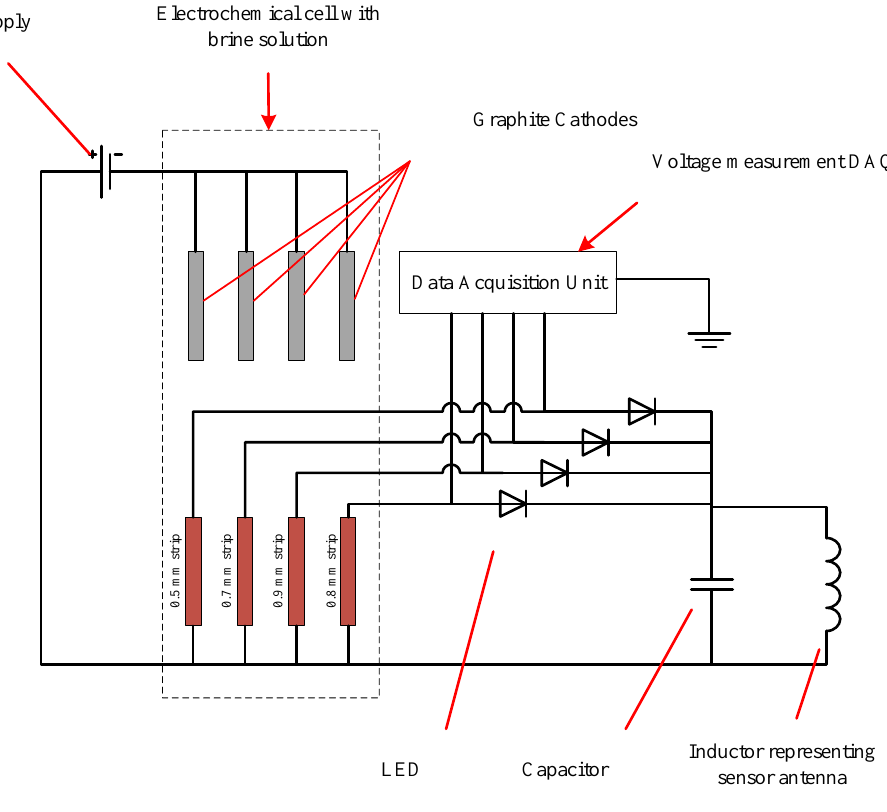
Figure 9. Schematic diagram of the corrosion test experimental